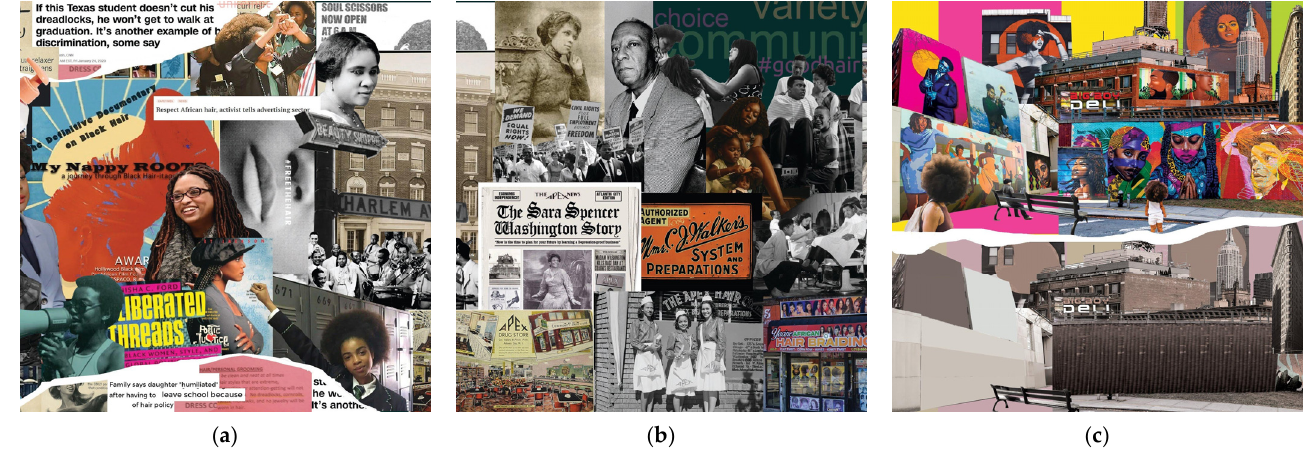
Figure 5. Natural Black hair movement, ( a ) key figures poster, ( b ) cultural placemaking poster, cre‑ ated by Joan A. Muranigra, 2022 ( c ) Pop Art and Natural Black Hair Radical movements posters, created by Joan A. Muranigra and Analise Lopez,